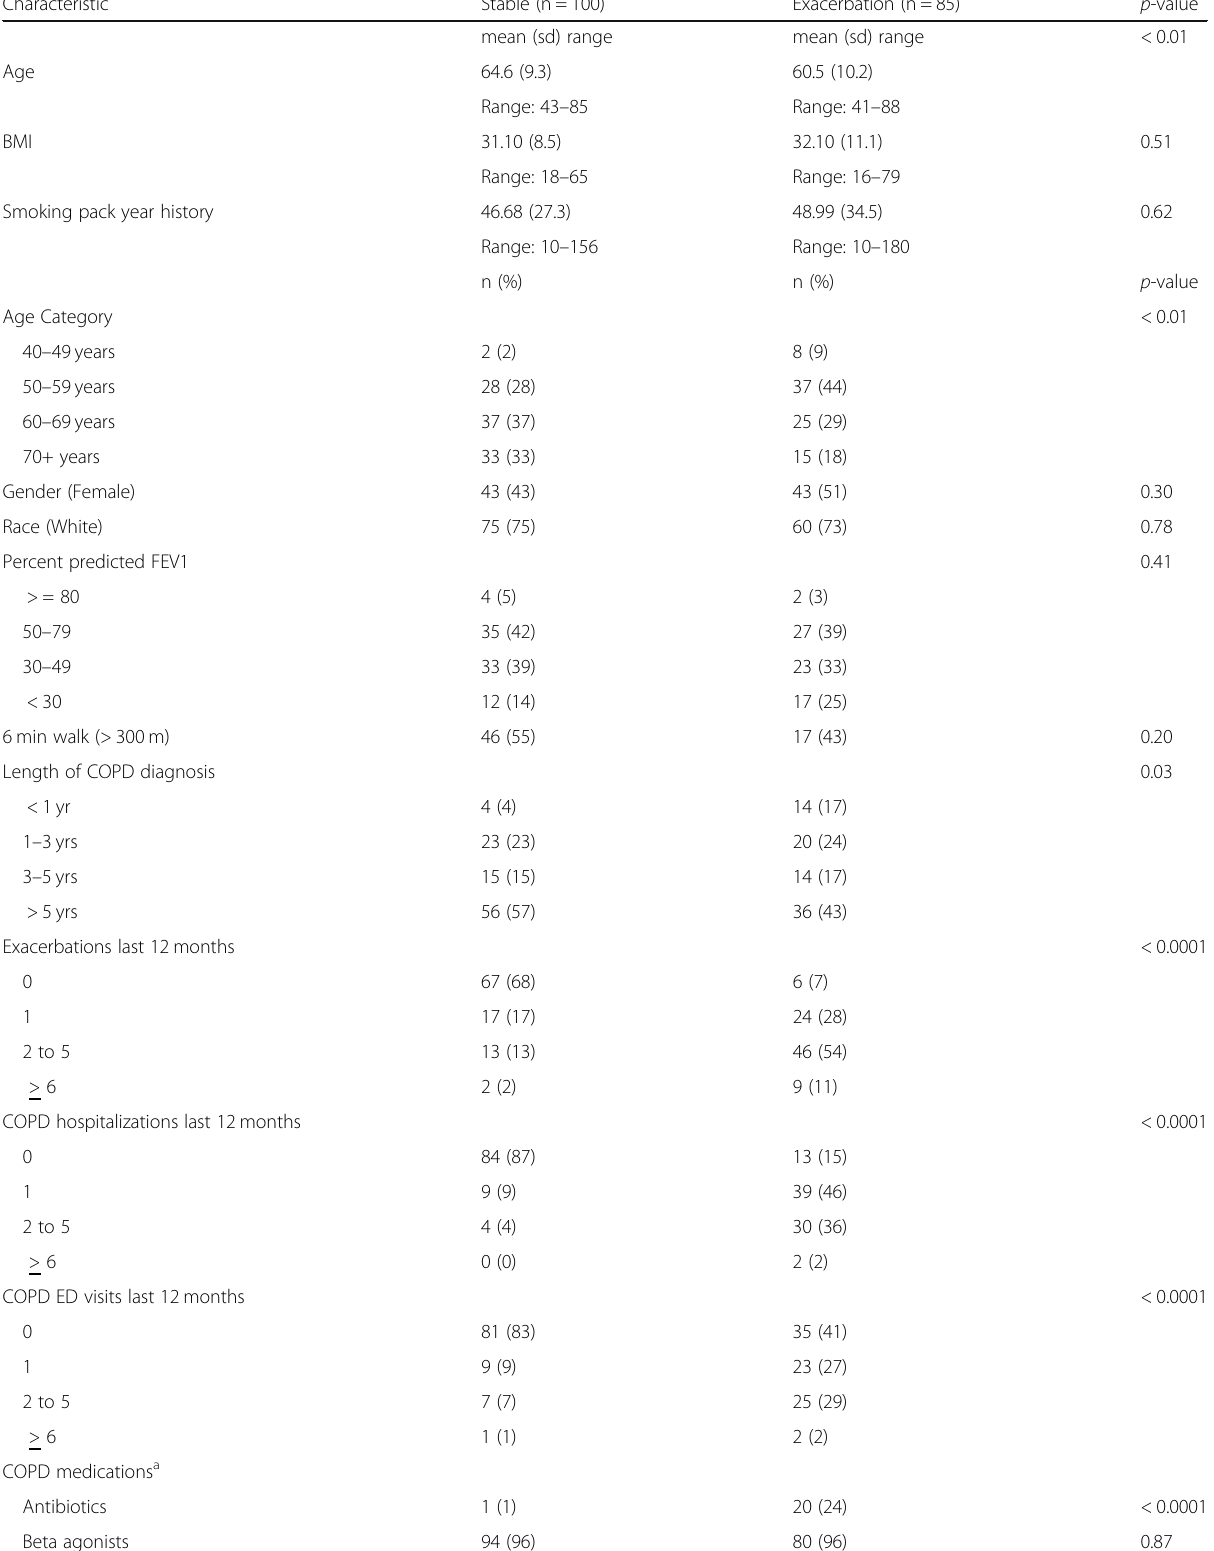
Table 2 Baseline Demographic and Clinical Characteristics of Enrolled